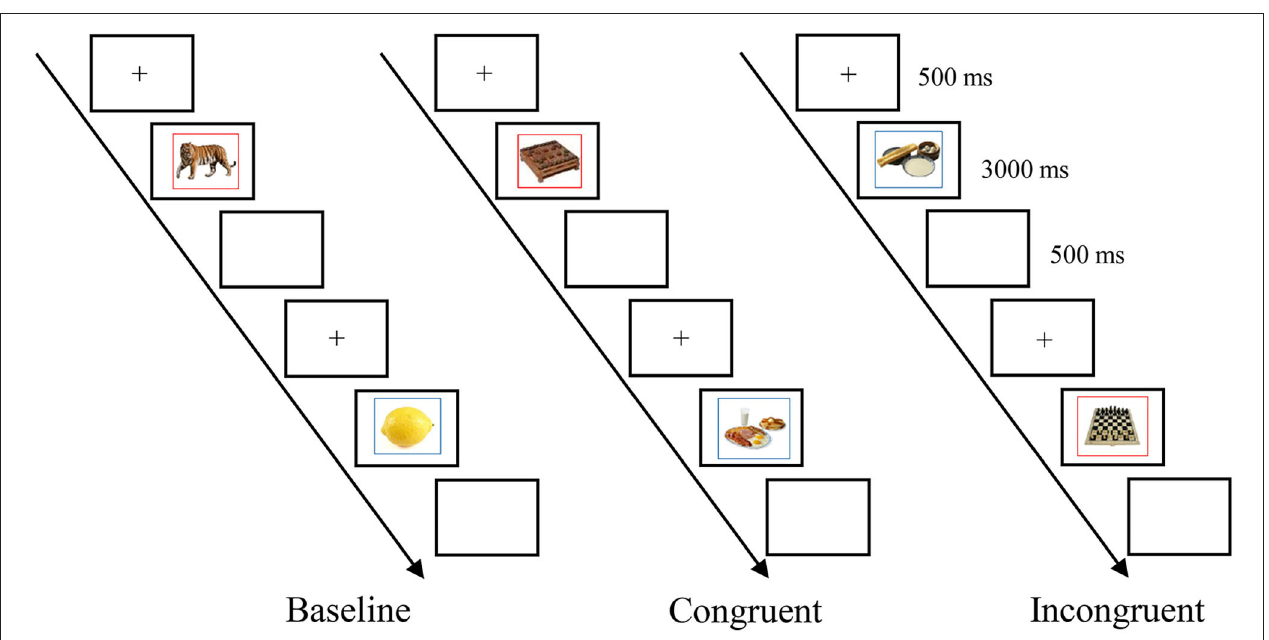
FIGURE 2 | The trial procedure for three